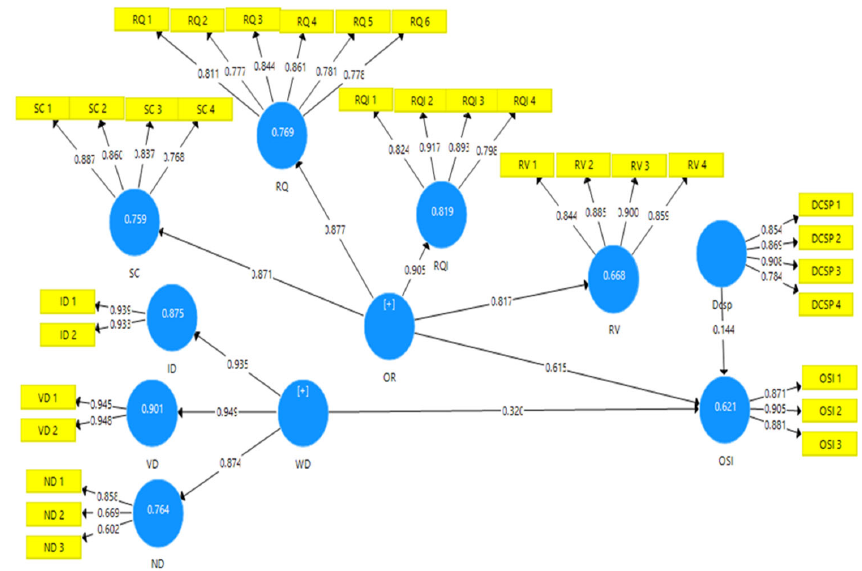
Fig. 1. The Measurement Model